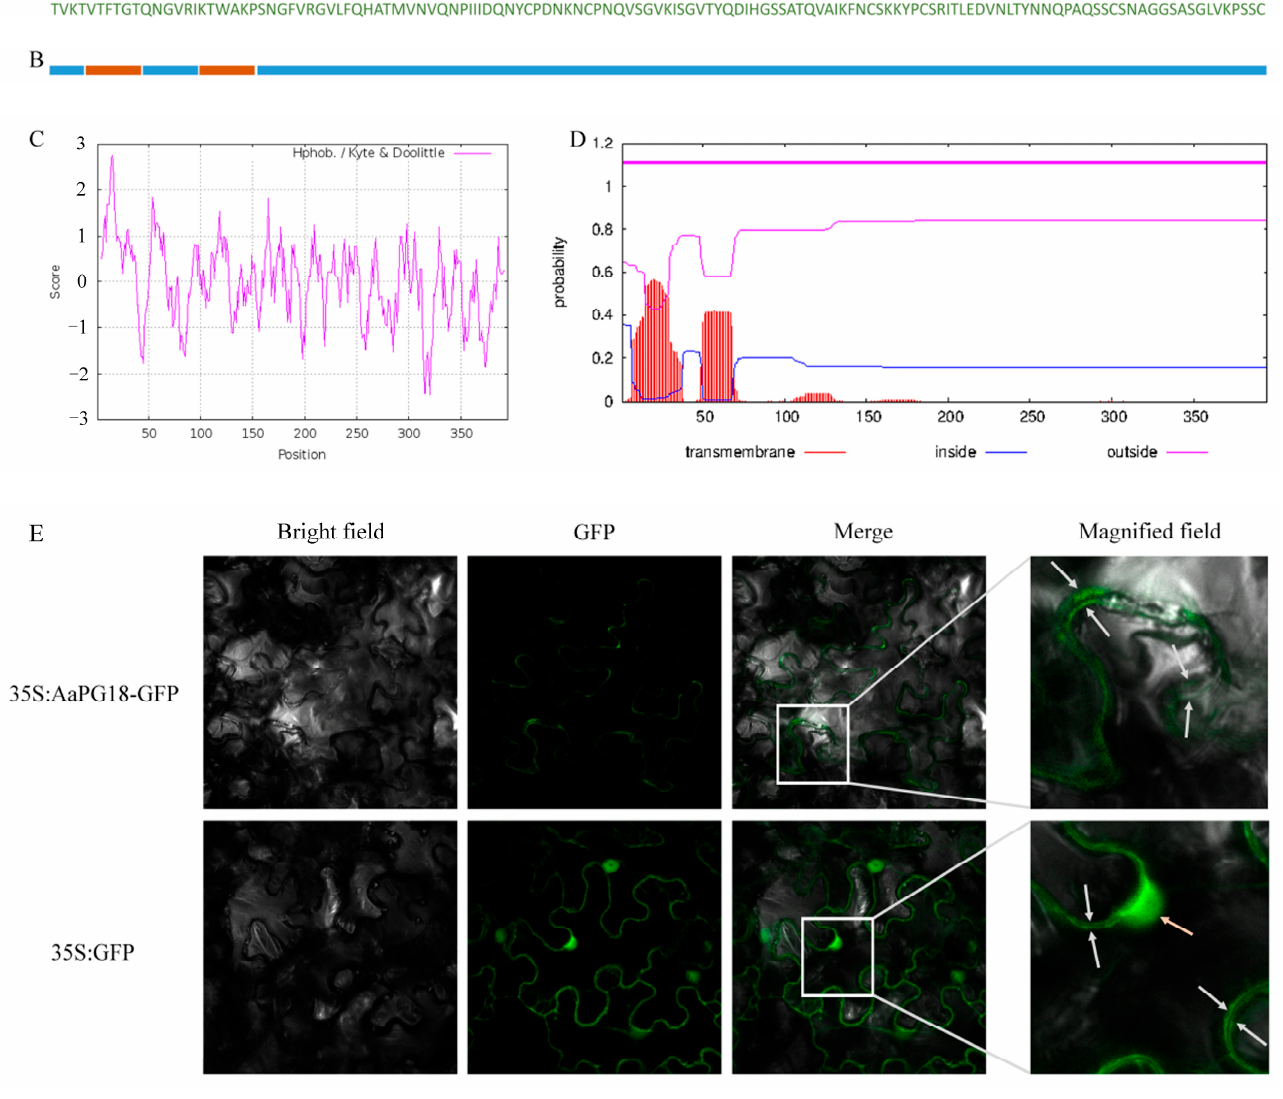
Figure 4. Protein structure analysis and subcellular localization of AaPG18. ( A ) Deduced protein sequence of AaPG18 with 395 amino acids. ( B ) Schematic representation of AaPG18 protein structure. Two possible N-terminus transmembrane domains (orange boxes) were included. ( C ) Hydropathic profile of AaPG18 protein using the predicting tool ProtScale (https://web.expasy.org/protscale/, accessed on 25 November 2021). ( D ) Prediction of transmembrane structure using TMHMM-2.0 (http://www.cbs.dtu.dk/services/TMHMM/, accessed on 25 November 2021). ( E )